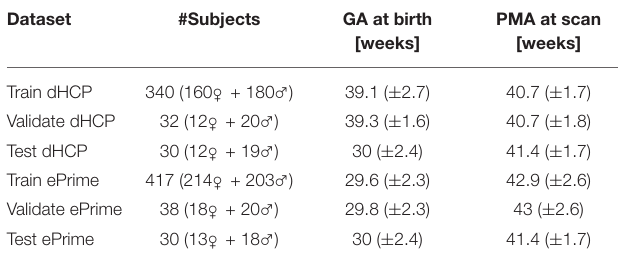
TABLE 1 | Number of scans in different datasets used for training, validation and testing the models, together with their mean GA and